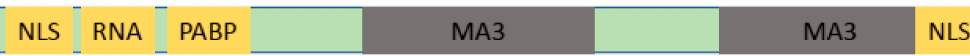
Figure 2. Schematic structure of PDCD4-protein. NLS, Nuclear localization signal; RNA, RNA binding site; PABP, poly(A) binding protein (PABP) binding site; MA3, MA3 domain homologous to eIF4G M1 domain. PDCD4 protein interacts with eIF4A through the MA3 domain and inhibits cap-dependent protein synthesis.